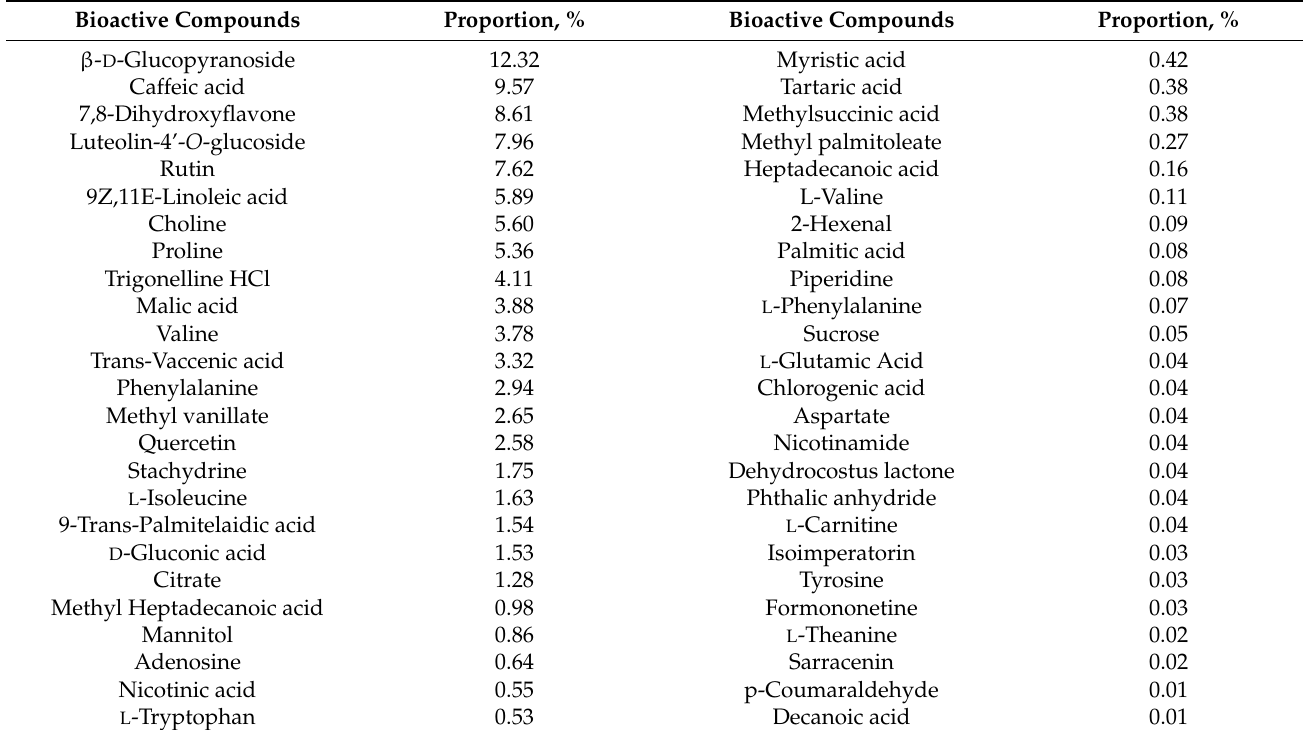
Table 2. The relative proportion of main bioactive compounds (% of total abundance of bioactive compounds) in dandelion (DAN) using LC/MS.